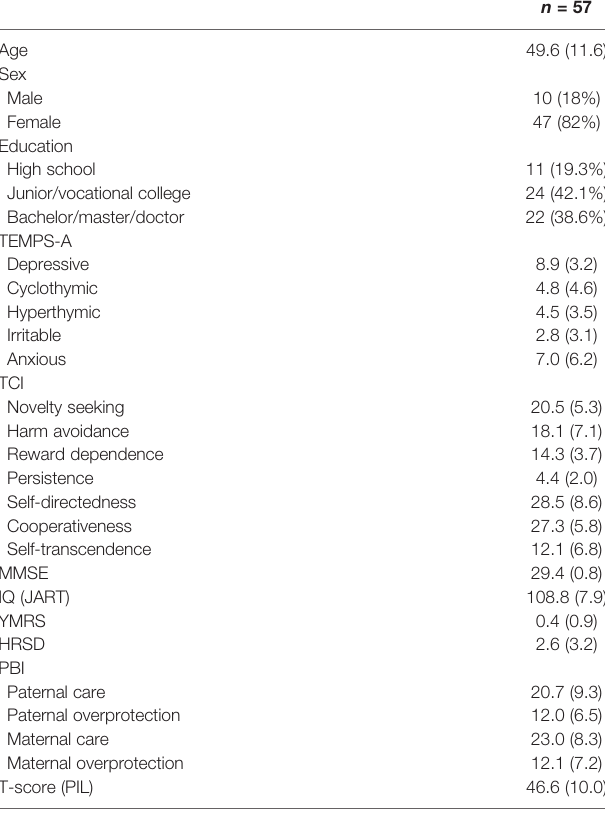
TABLE 1 | Participant Demographics and psychological fi